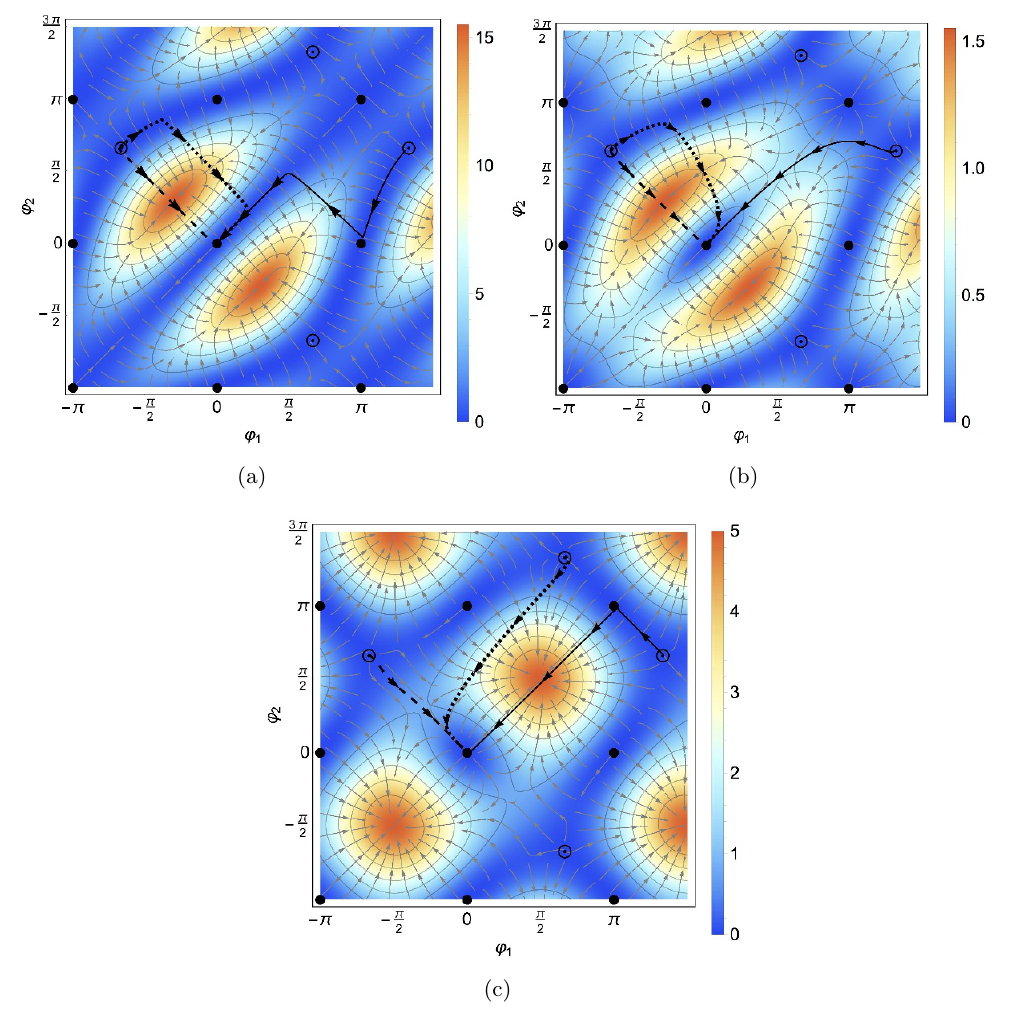
Figure 5 . The potential V ( ’ 1 ; ’ 2 ) and its gradient-(cid:13)ow ~ r V for the case of SU(3) in which (cid:13) 1 = (cid:13) 2 = (cid:13) 3 = 1 and the coupling parameter (cid:21) takes the values (a) (cid:21) = (cid:0) 1 : 8, (b) (cid:21) = 0 and (c) (cid:21) = 1 :